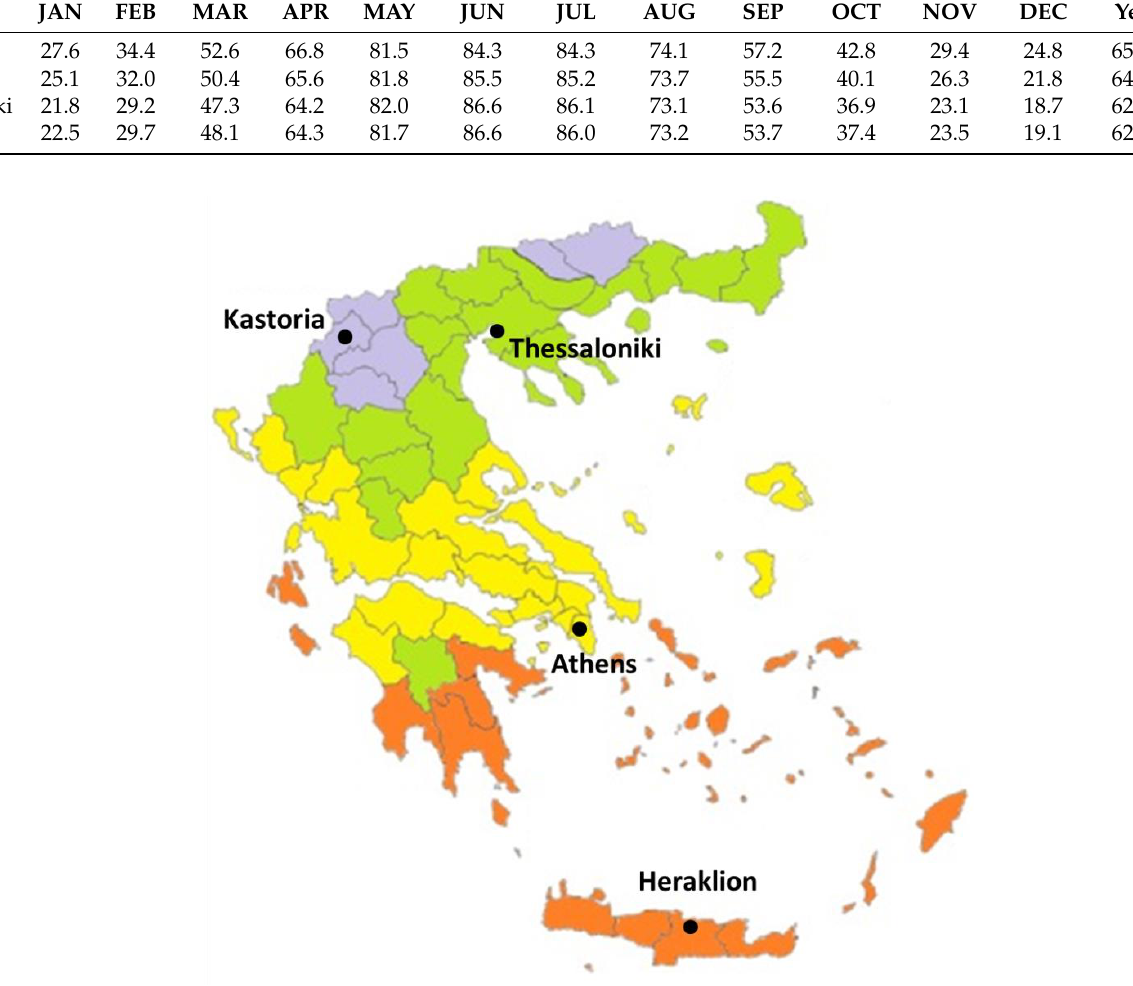
Greece. More specifically, in the work Zone A is examined with the city of Heraklion